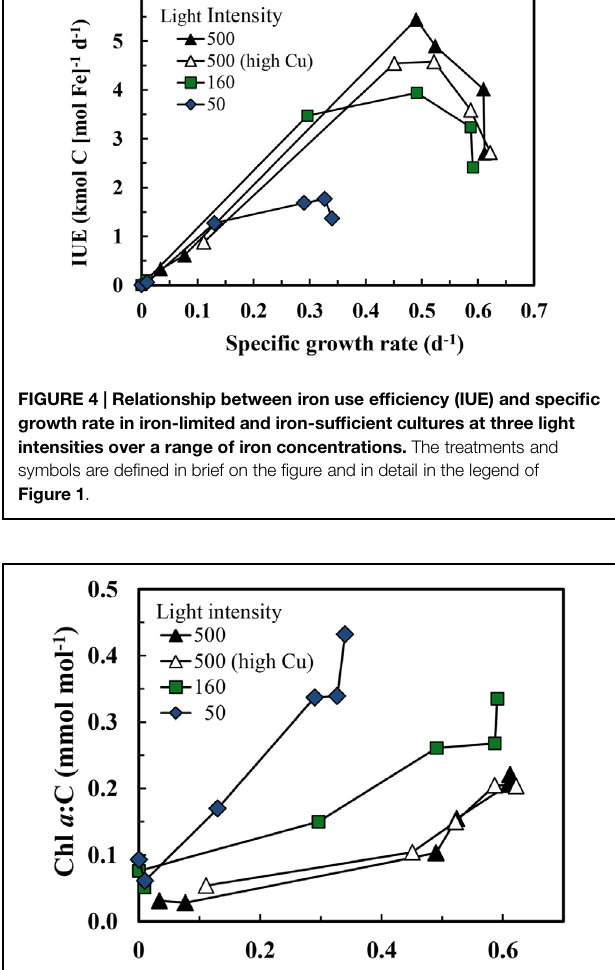
FIGURE 3 | Relationships between specific growth rate and cellular Fe:C molar ratio in S. bacillaris at different light intensities. The treatments and symbols are defined in brief on the figure and in detail in the legend of Figure 1 . The dashed lines give the expected relationships between the specific growth rate and metabolic iron normalized to cell C at the three light intensities based on the relationships between specific growth rate and cellular Fe:C in coastal eukaryotic species Thalassiosira pseudonana and Prorocentrum minimum (Sunda and Huntsman, 1997, 2011).